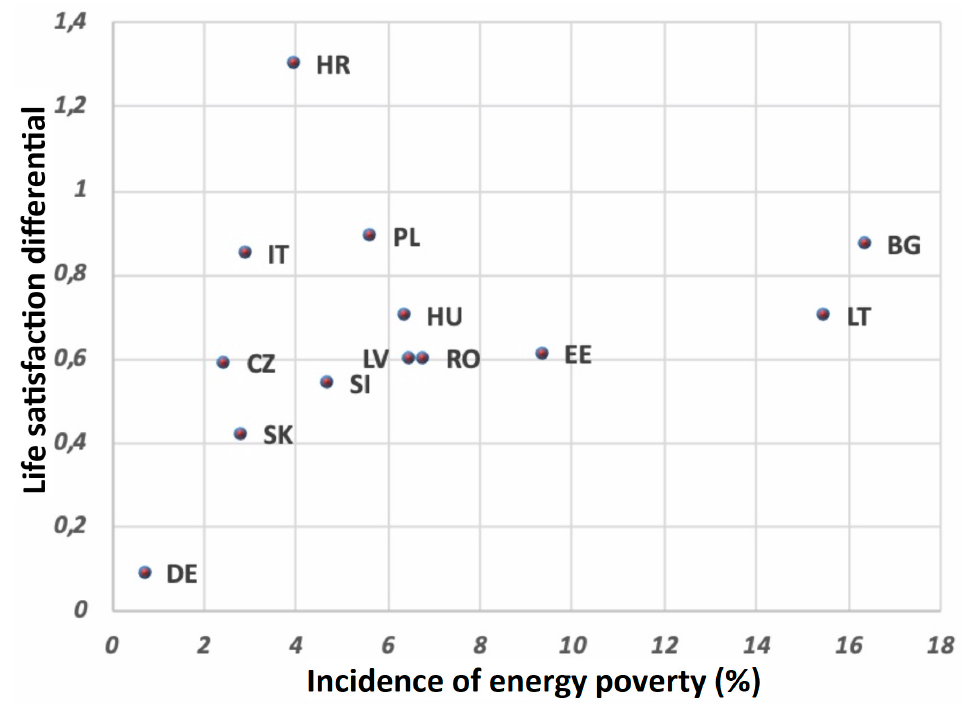
Figure 1. Life satisfaction differential between non-energy poverty and energy poverty groups in relation to energy poverty incidence. Note: BG—Bulgaria, HR—Croatia, CZ—Czech Rep., EE—Estonia, DE—Germany, HU—Hungary, IT—Italy, LV—Latvia, LT—Lithuania, PL—Poland, RO—Romania, SK—Slovak Rep., SI—Slovenia.